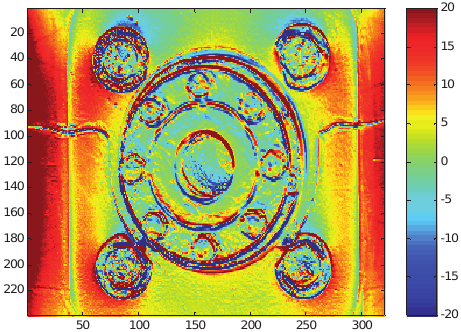
Fig. 11. TSA obtained for the load of bending out of plane